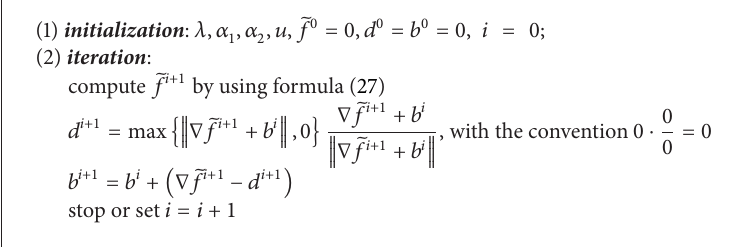
Algorithm 1: The split Bregman scheme for subproblem